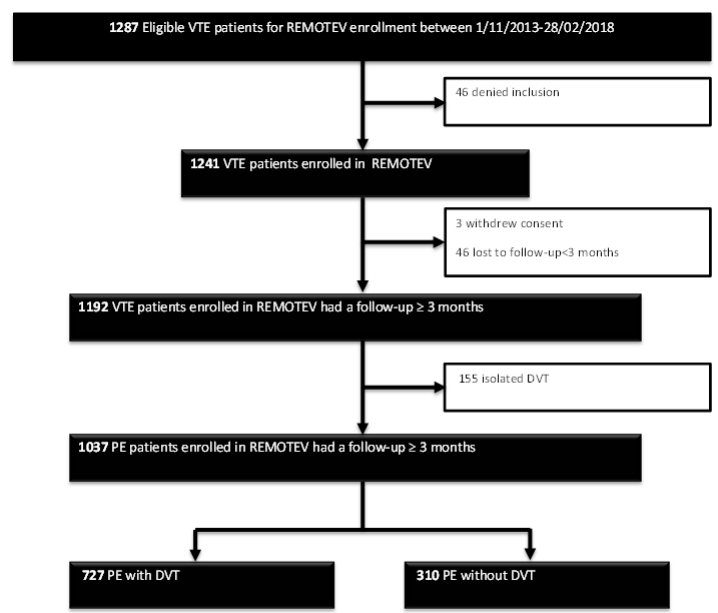
Figure 1. Study flowchart. DVT: deep vein thrombosis; PE: pulmonary embolism; VTE: venous thromboembolism. PE: pulmonary embolism; REMOTEV: Observational Prospective Monocentric Registry of Patients Suffering From Venous Thromboembolism.